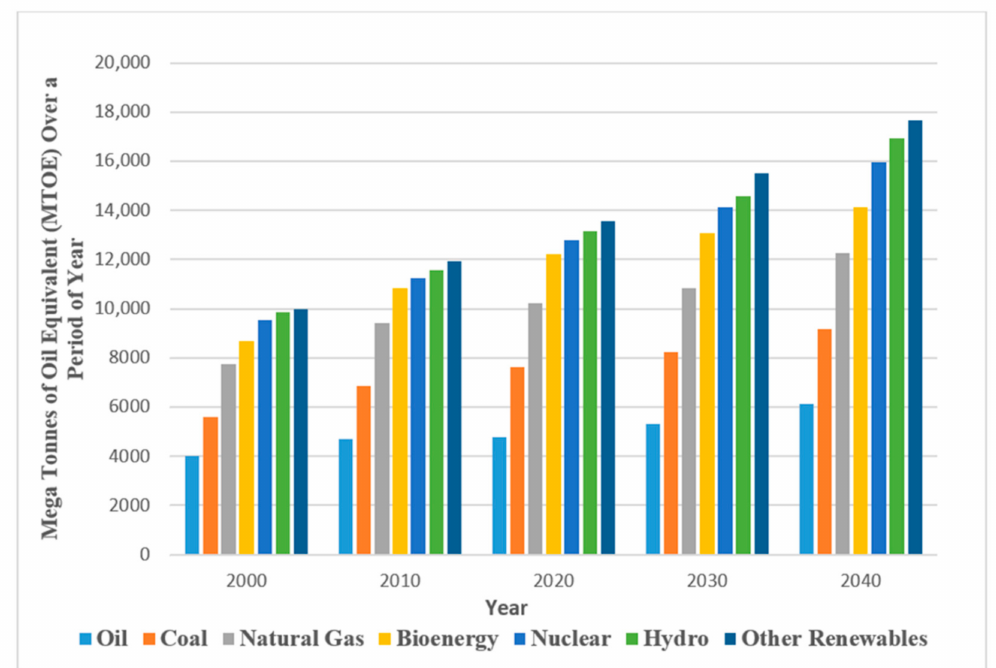
Figure 1. Global crude oil and energy demand. The data used were generated based on average from reference